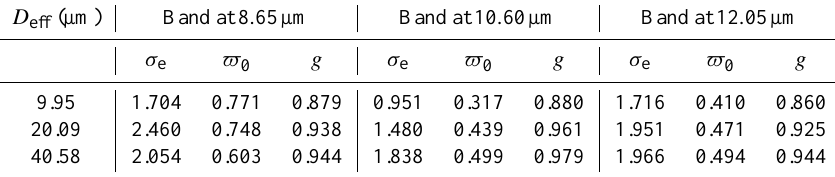
Table 2. Optical parameters for aggregate ice crystals of the P. Yang model (Yang et al., 2001, 2005) used in cirrus 1 to 8 and CII-3.